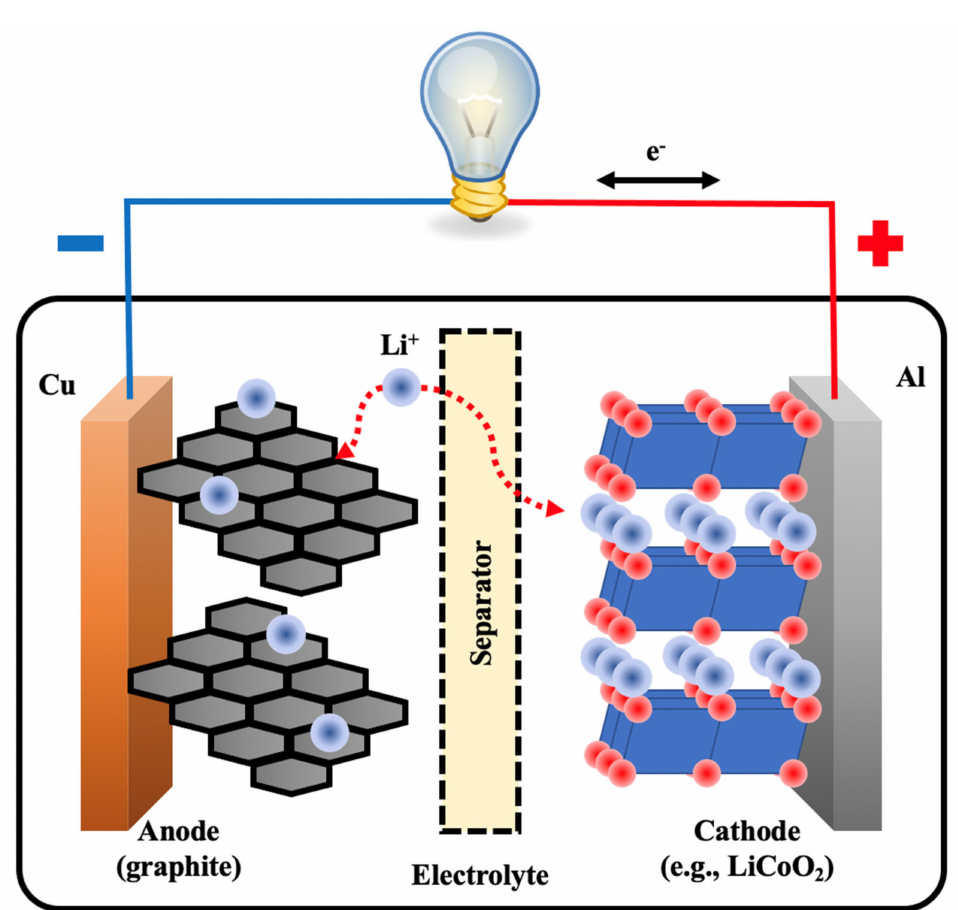
Figure 1. Schematic of a LiB. The lithium ions are moving from the anode to the cathode during discharge, and from the cathode to the anode during charging. Correspondingly, the electrons circulate through the external